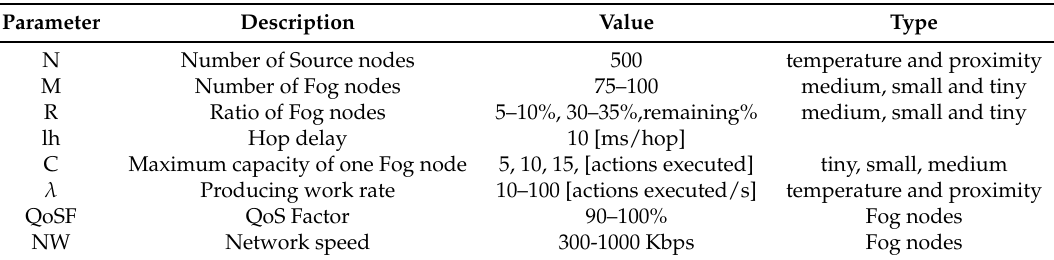
Table 5. Evaluation parameters.